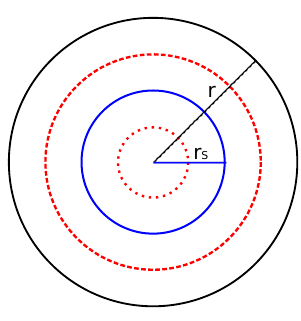
Figure 9 . A schematic view of the scales in our theory. The blue solid circle shows the Schwarzschild radius of a black hole ( r S GM ), and the black solid circle shows the orbit of the second black (cid:24) hole with radius r . The dashed and dotted red circles are two possible choices of the scale (cid:3) for a given black hole: 1 = (cid:3) ? r S , that lead to di(cid:11)erent qualitative contributions, and that are discussed in the